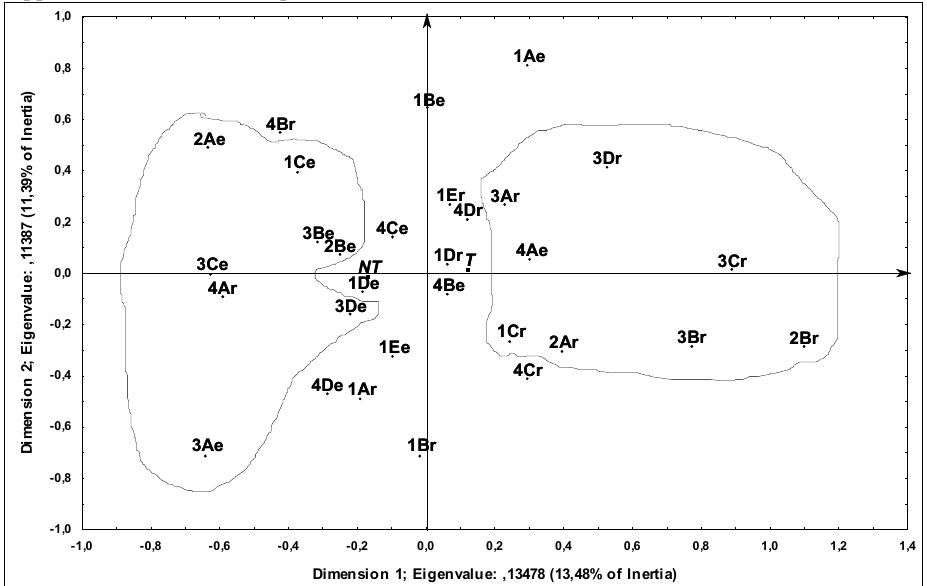
Tableau 4. Pourcentages d’inerties corrigées (benzécriennes) et leurs cumuls.